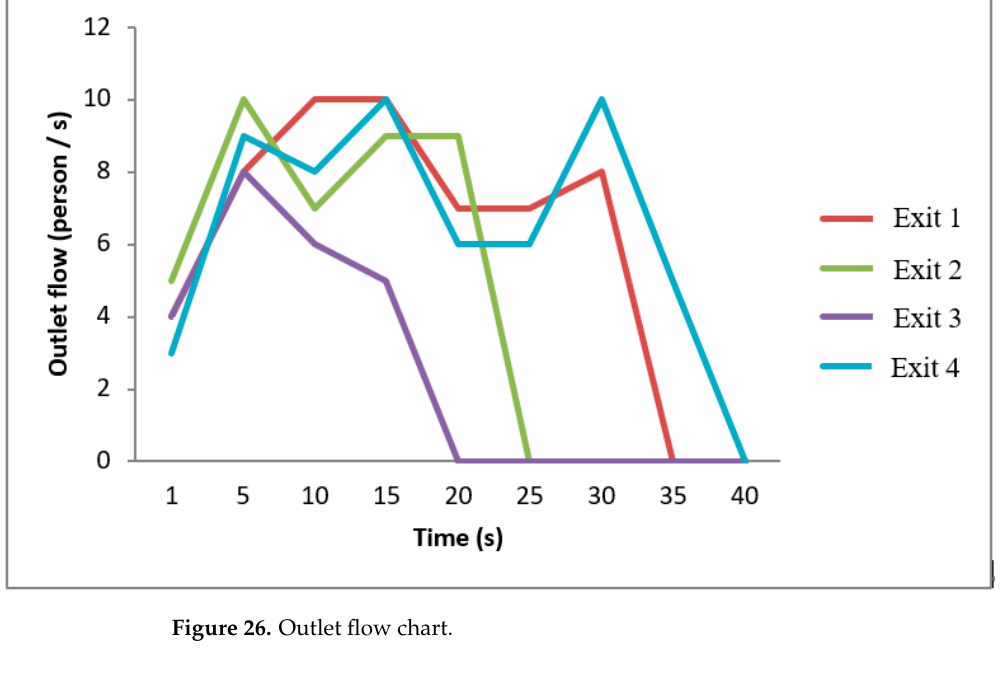
Figure 26. Outlet flow chart.